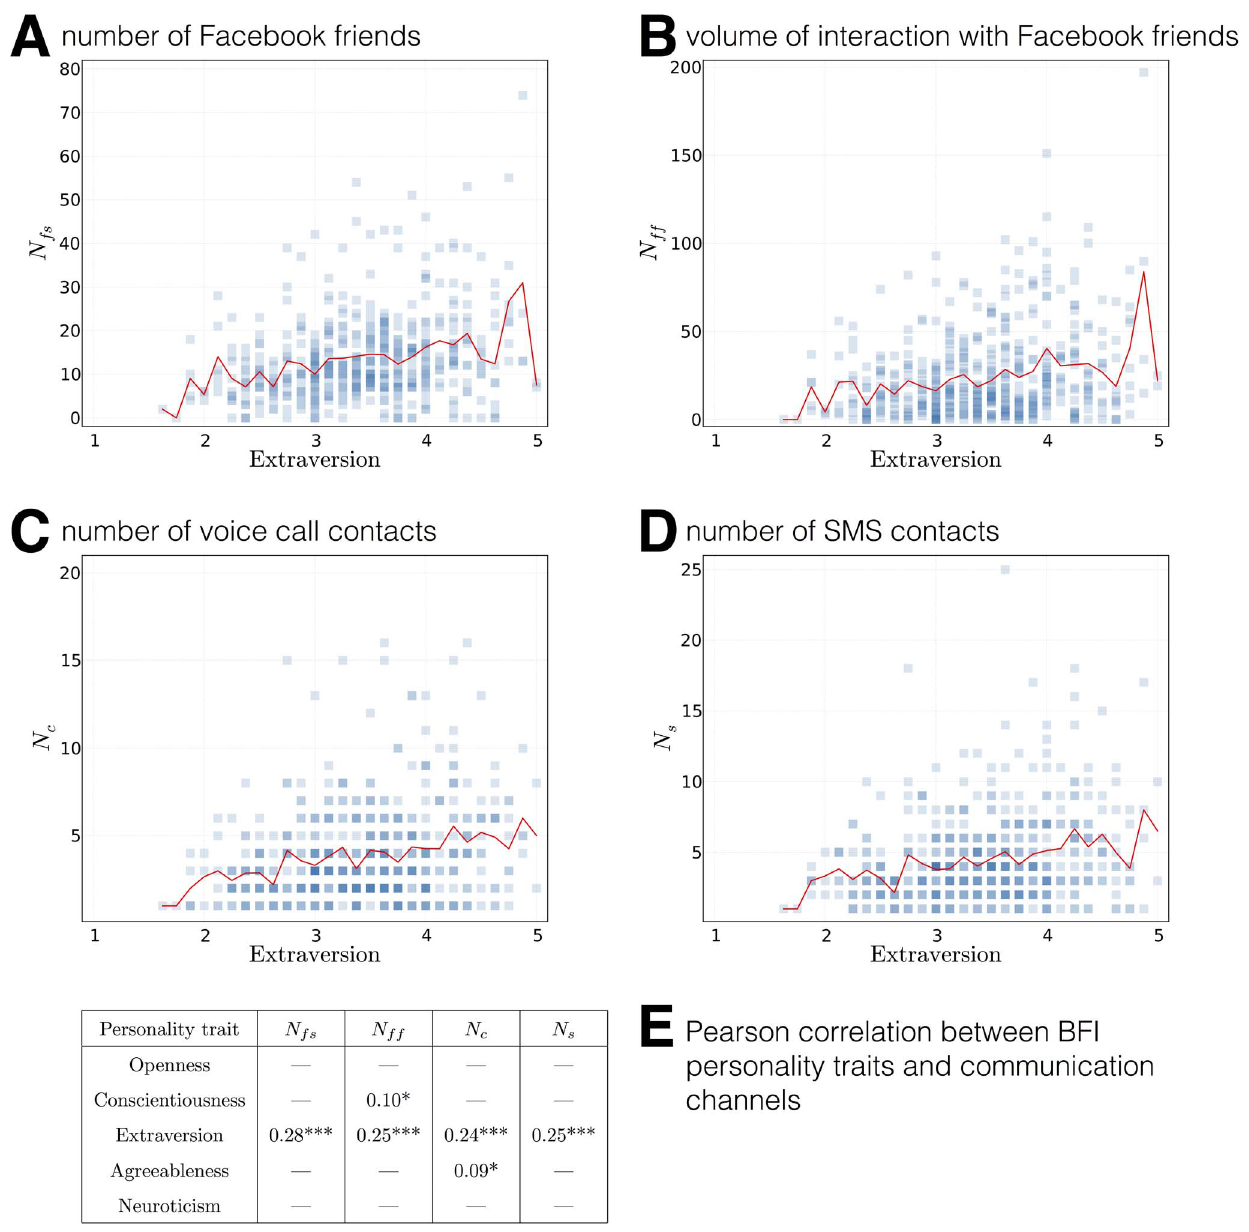
Figure 15. Correlation between personality traits and communication. Data from the 2013 deployment for N=488 participants, showing communication only with other study participants. Extraversion, the only significant feature across all networks is plotted. The red line indicates mean value within personality trait. Random spikes are due to small number of participants with extreme values. E ) Pearson correlation between Big Five Inventory personality traits and number of Facebook friends N fs , volume of interactions with these friends N ff , number of friends contacted via voice calls N c and via SMS N s . *: p v 0 : 05 , **: p v 0 : 01 , ***: p v 0 : 001 .